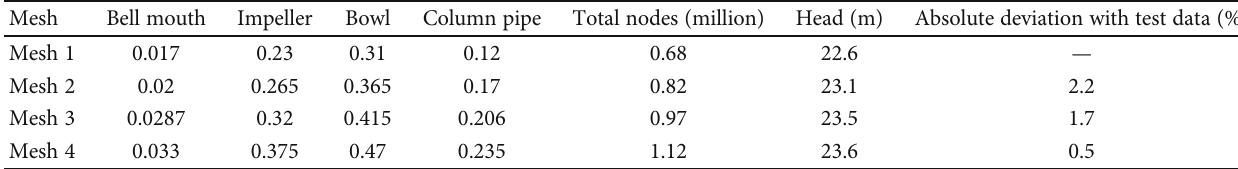
Table 2: Details of mesh statistics of four test cases.